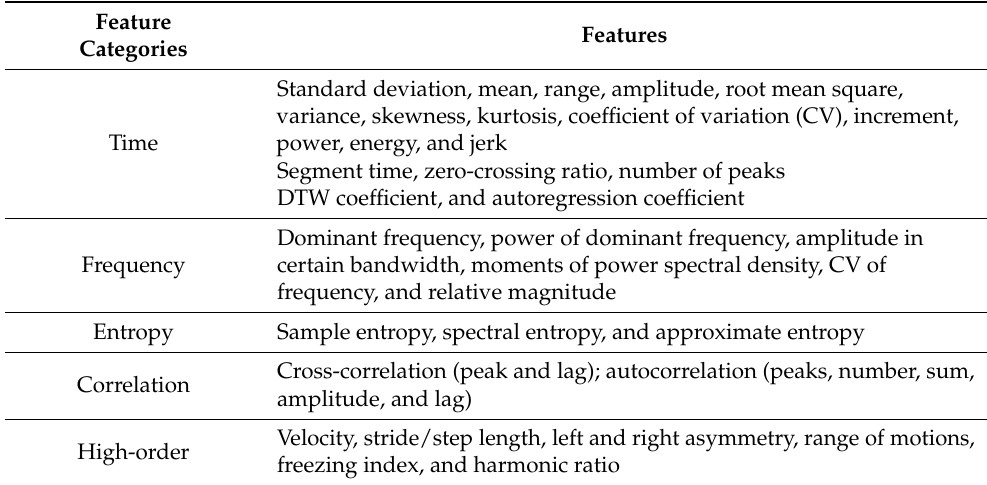
Table 1. Feature groups for supervised machine learning